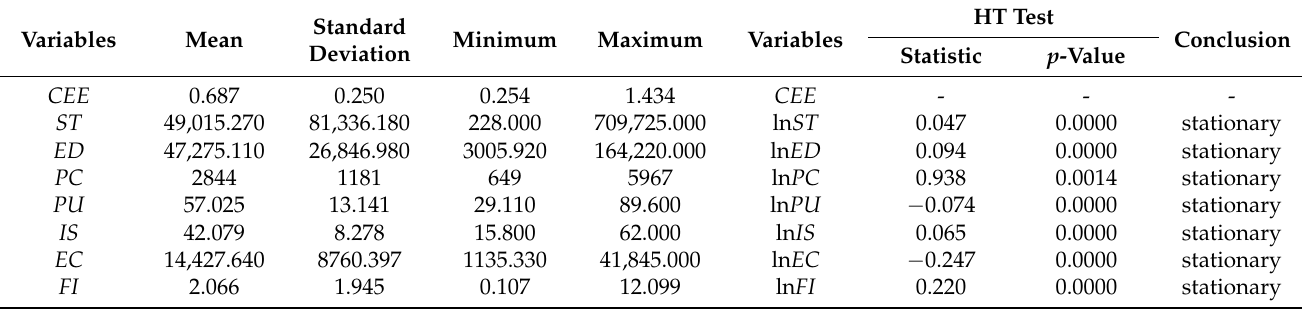
Table 2. Descriptive statistics for